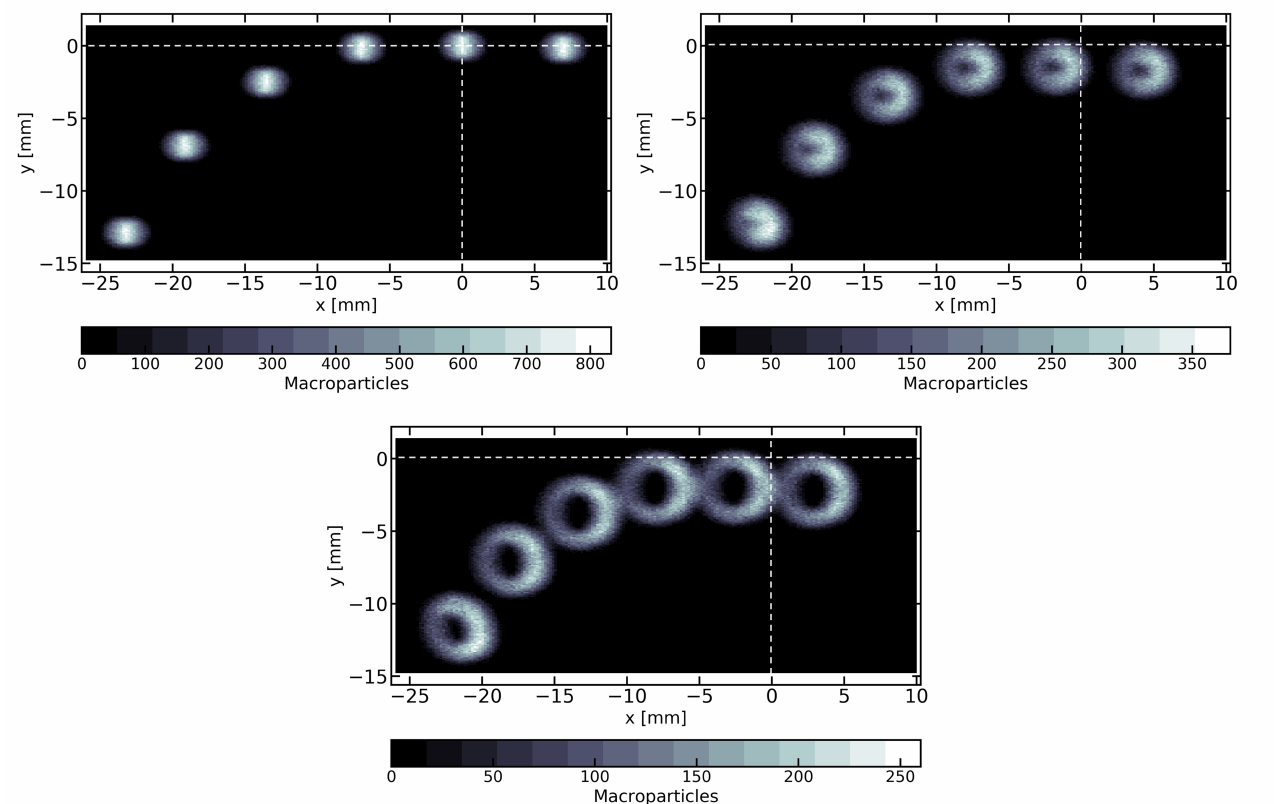
Figure 13. The effect of a plasma column rotating around the beam axis on six proton pencil beams as simulated with BDSIM [65] for electron densities of 0m − 3 , 1.8 × 10 14 m − 3 , and 2.8 × 10 14 m − 3 . Increasing the density of the plasma modifies the separation and the width of the rings. The plasma column has a radius r c = 14mm and an offset D = 7mm from the central axis of the